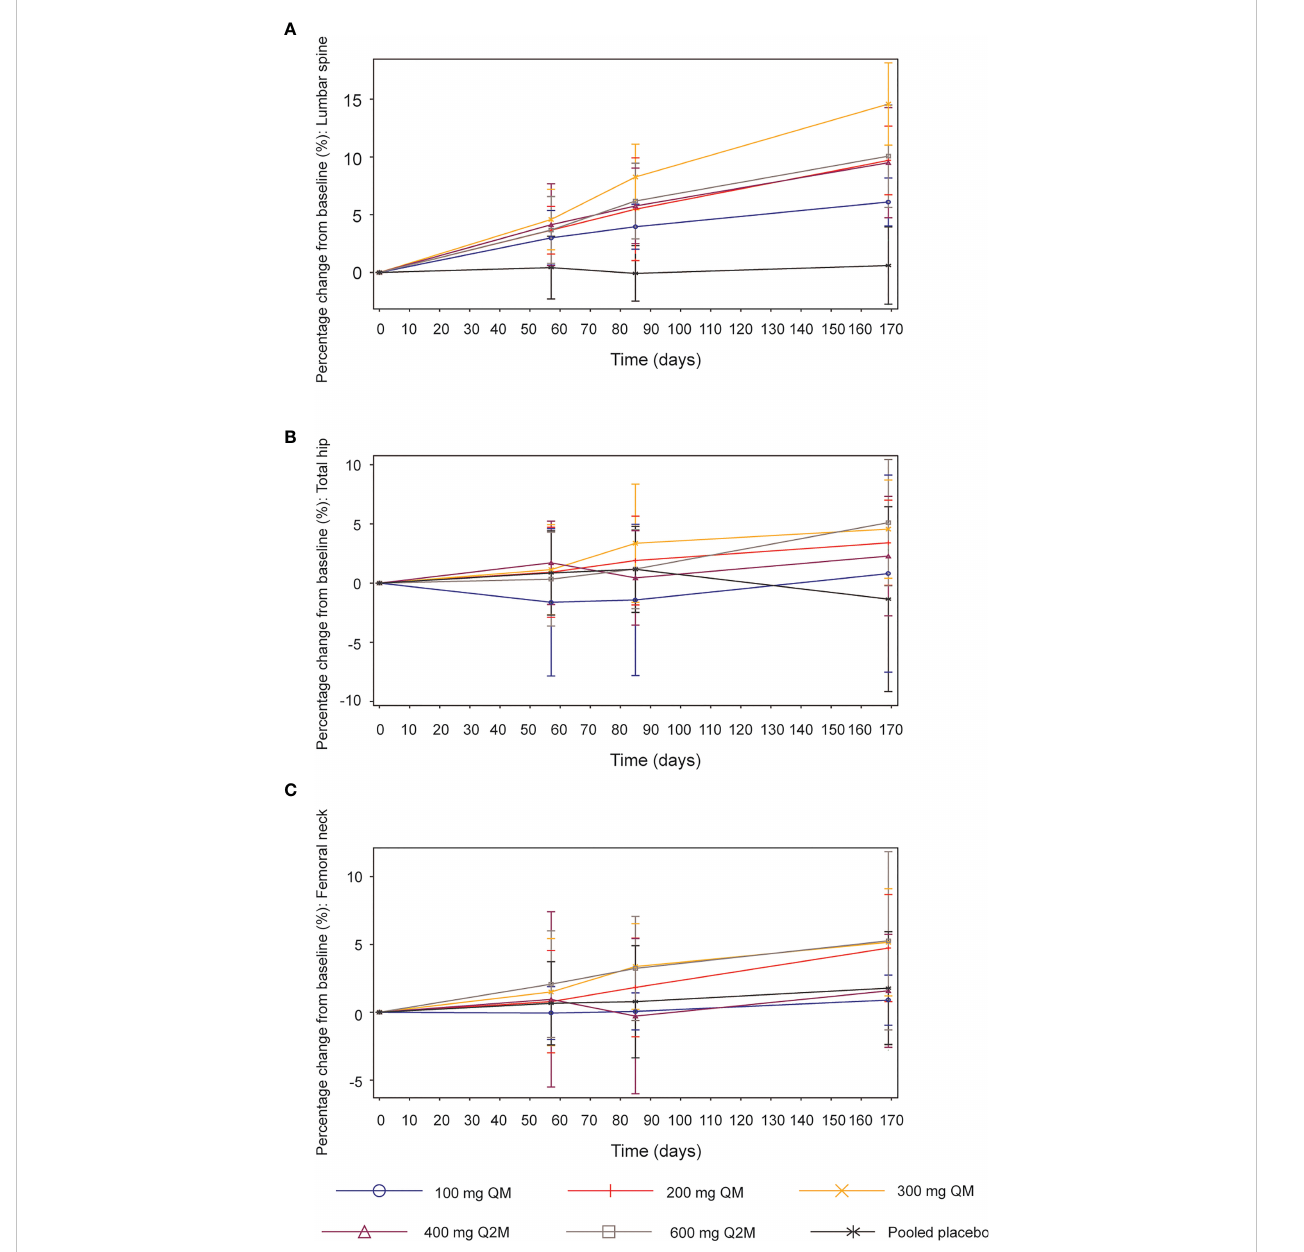
FIGURE 4 Mean (SD) percentage changes from baseline in bone mineral density (BMD). (A) Lumbar spine. (B) Total hip. (C) Femoral neck. SD, standard deviation; QM, once every month; Q2M, once every 2